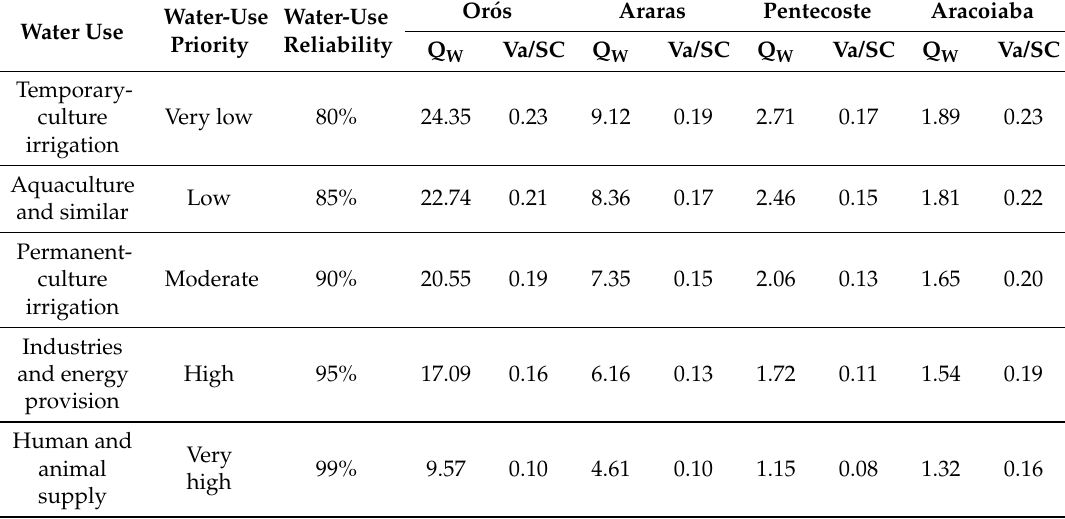
Table 2. Example of simulation. Withdrawal discharges (Q W , in m 3 /s) and the ratio between alert volume (Va) and the storage capacity (SC) for the focus reservoirs, considering five water-use priorities and their respective annual supply reliability. Simulation parameters consider reservoir